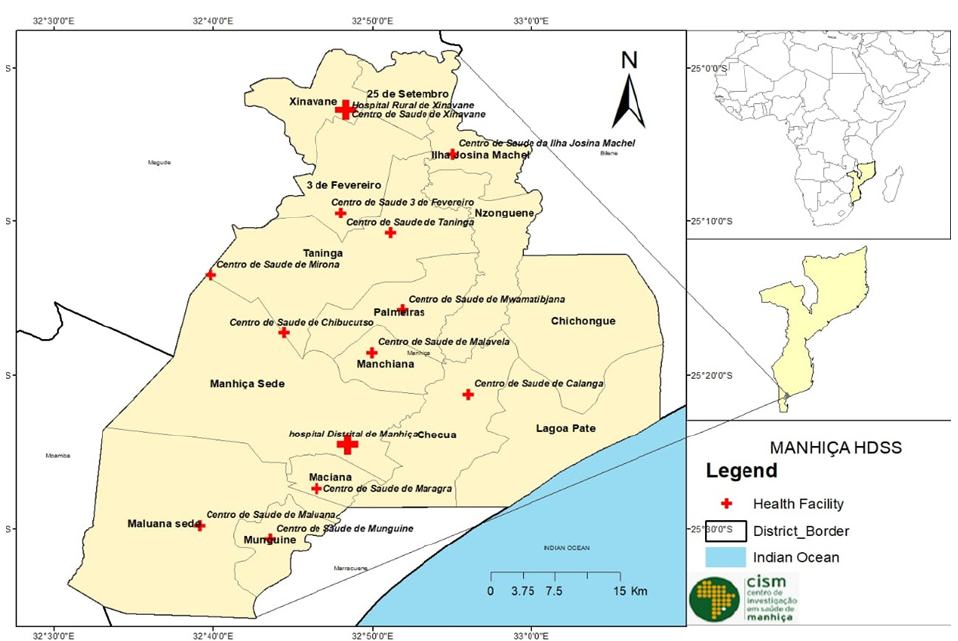
Figure 1. Map of Manhiça district (2021) covering the Manhiça Health and Demographic Surveillance System (HDSS), by the authors. (A) Administrative shape files were obtained from CENACARTA. (B) GPS positions of health facilities were obtained directly from the field by the